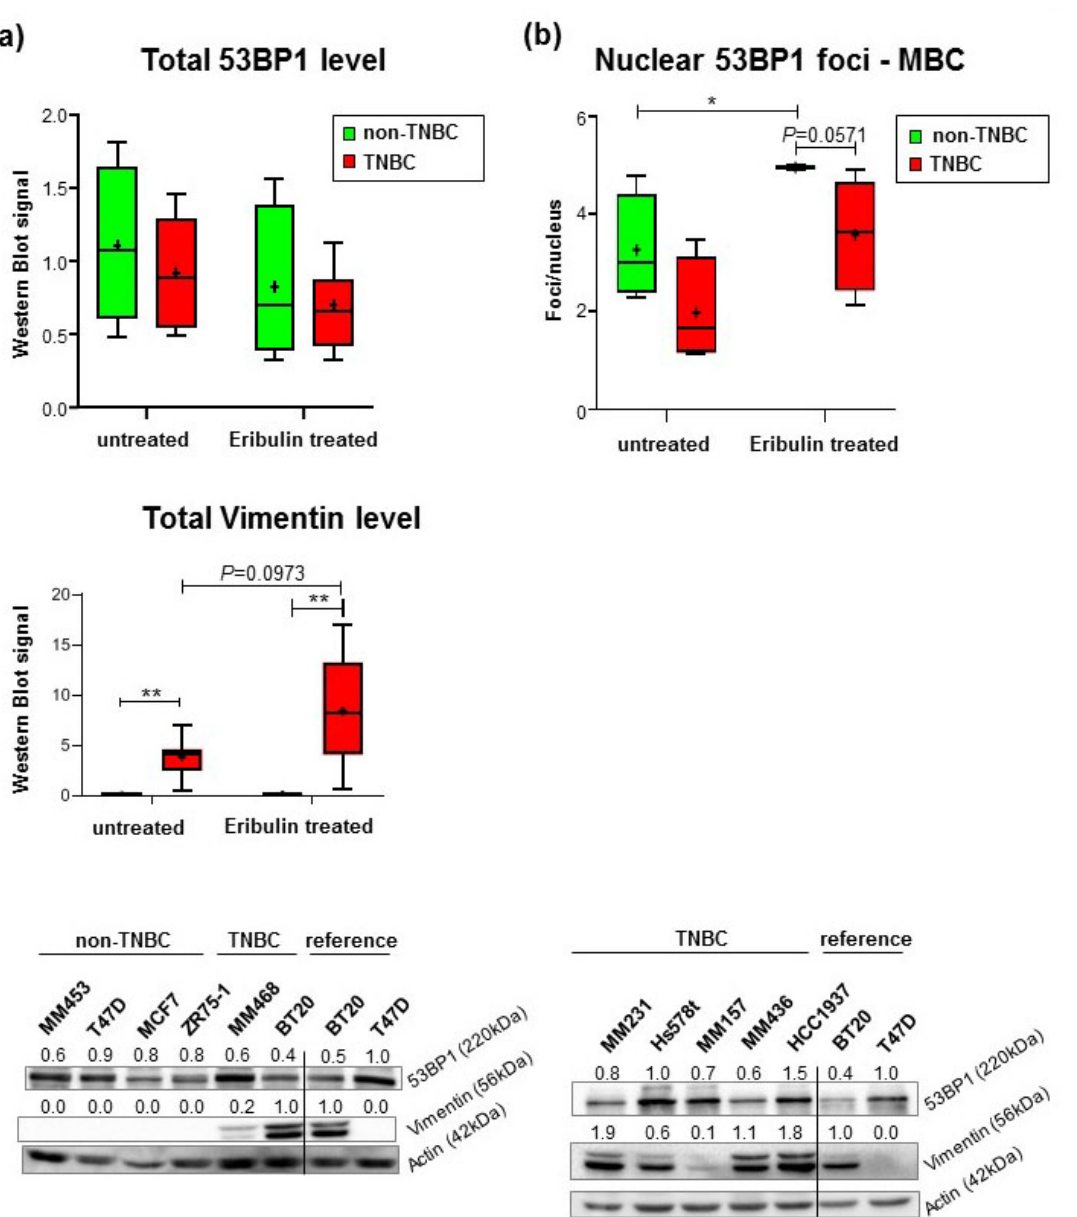
Figure 3. Protein expression and nuclear foci formation in breast cancer cell lines. ( a ) Cellular protein levels. 53BP1 and Vimentin band intensities were normalized to loading controls. Values for T47D cell extracts, loaded as a reference on each blot, were set to 1. Mean relative Western blot signals per cell line were calculated from two independent experiments. Box plots in the upper panels show mean values (cross), the median (line), and 95% CI (whiskers) for untreated and for 7d Eribulin-treated non-TNBC (N = 4) and TNBC cell lines (N = 7). The Kruskal–Wallis test did not reveal significant differences in the case of 53BP1. Representative immunoblots are shown in the bottom panels. Vimentin staining was detected in all TNBC but was negative in all non-TNBC cell lines in which BT20 served as a reference. Actin normalized protein levels are indicated above the 53BP1 and Vimentin signals. ( b ) Focal accumulation of 53BP1 in the nucleus of MBC cell lines. 53BP1 foci were detected by immunofluorescence microscopy in MBC cell lines. The graph presents quantitative data in box plots as in A; ~300–900 nuclei per sample were scored in two independent experiments each, and mean values were calculated for each cell line. *P < 0.05, Kruskal–Wallis test, Mann–Whitney U test. Representative immunofluorescence images are displayed in Supplementary Figure 3.